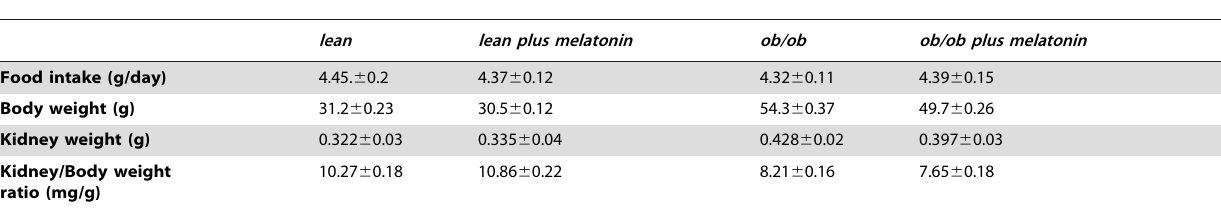
Table 1. Food intake, body and kidney weights.